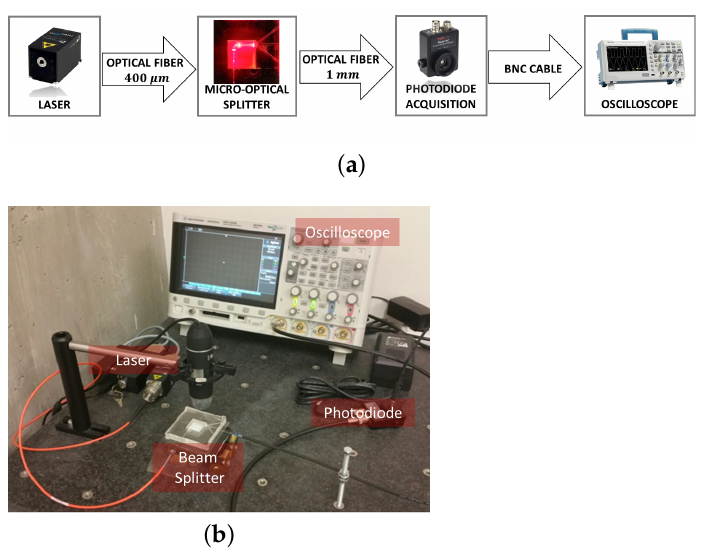
Figure 6. ( a ) The flow chart and ( b ) the picture of the experimental set-up used for the micro-optical characterization of the PDMS- µ SPT . At the input, the laser source is connected to a multi-mode optical fiber. At the output, a fiber is coupled with a photo-diode and a digital oscilloscope is used for the reading. Both fibers are aligned with the µ SPT